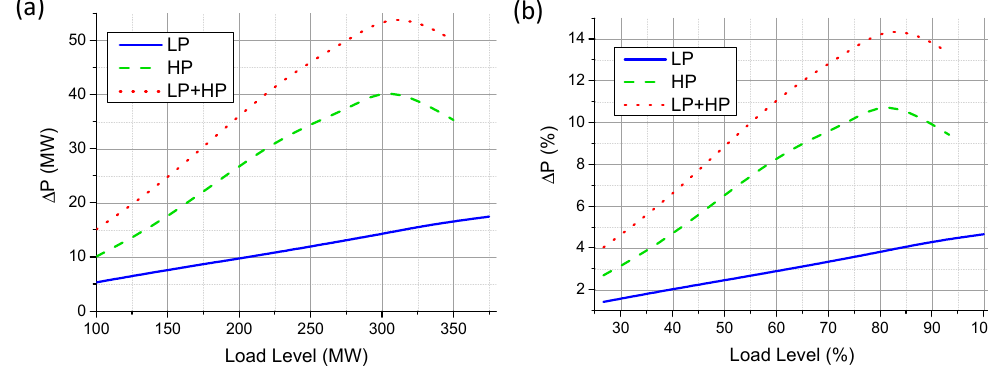
Figure 18. Power plant capacity increase ( Δ P ) for the TES discharging process: ( a ) in MW; ( b ) in % of registered capacity; where, LP: low pressure feedwater preheater bypass; HP: high pressure feedwater preheater bypass; HP + LP: both LP and HP feedwater preheaters bypass.